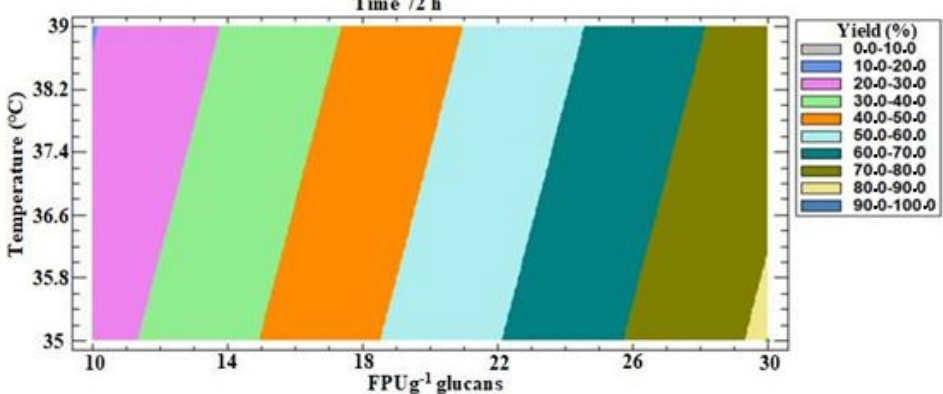
Figure 4. Contours of the estimated response surface of Model II (72 h).